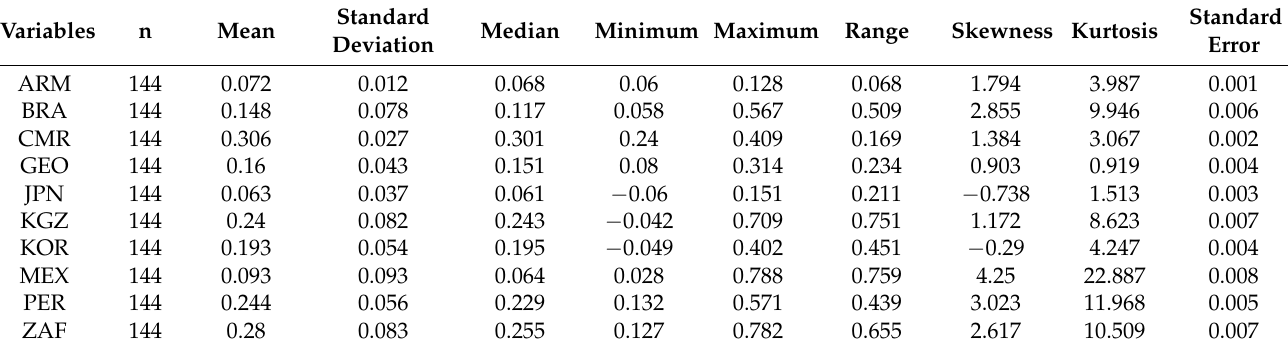
Table 7. Descriptive statistics on the estimated DCC.